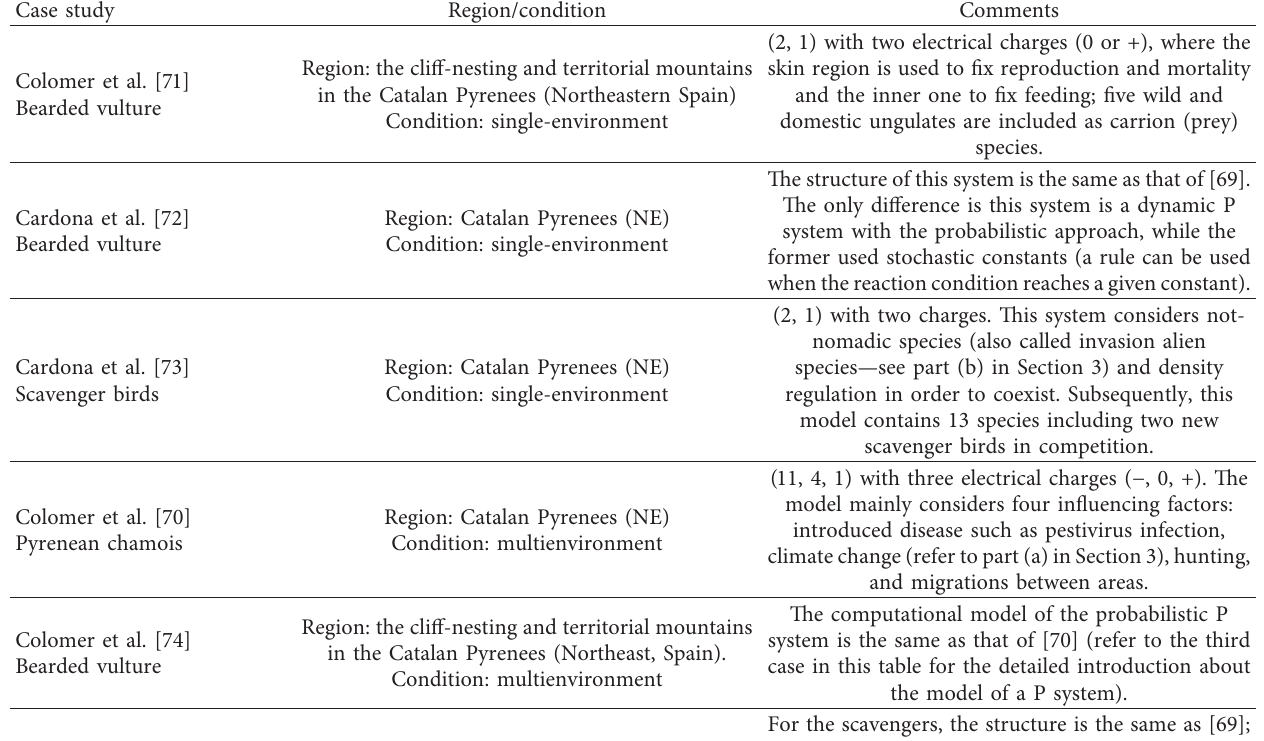
Table 1: Summary of studies that have used a new frontier approach, termed PDP systems with different constraints, to assess the number of endangered species under conditions of different